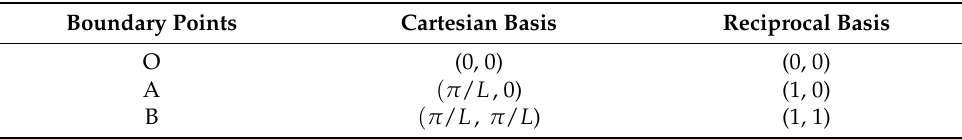
Table 1. Coordinates of the boundary points of the